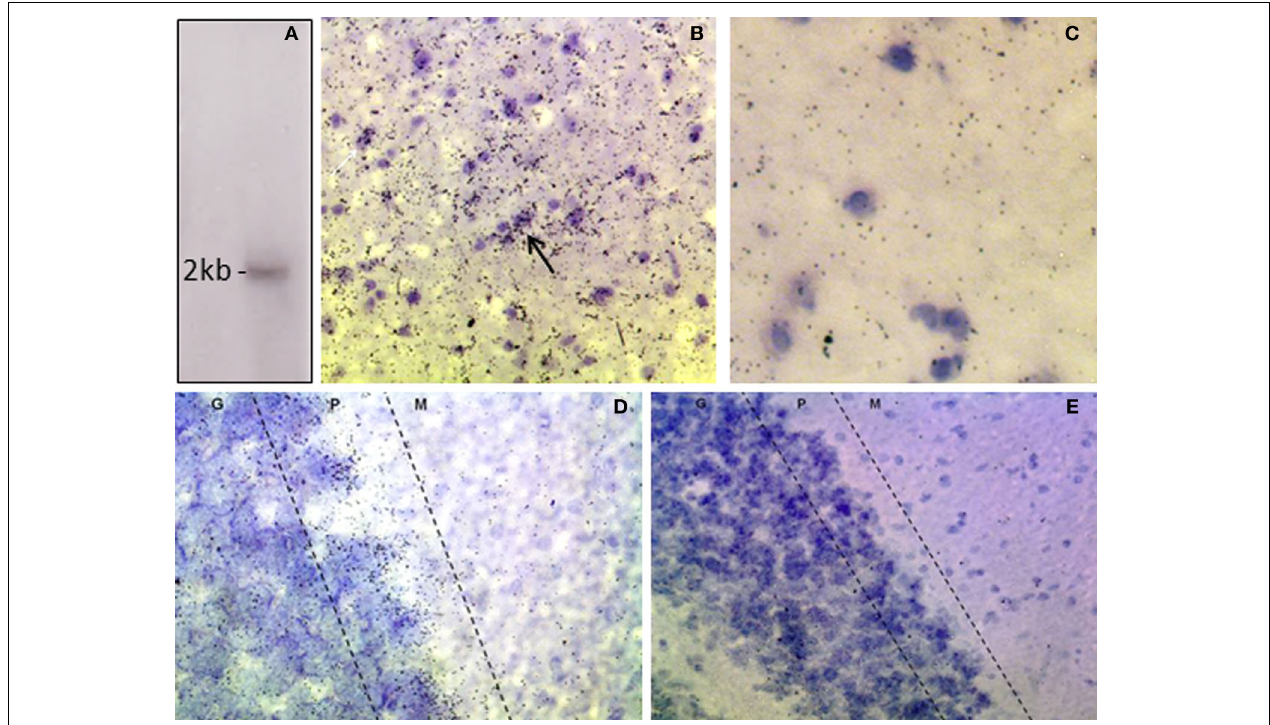
FIGURE 1 | Expression of DAO mRNA in rat VTA and cerebellum. (A) Northern blot of rat cerebellar RNA showing that the DAO cRNA probe detects a single band of ∼ 2kb. (B) In situ hybridization, showing signal for DAO mRNA in the VTA, with clusters of grains over neurons (arrow). (C) VTA, sense strand hybridization control, showing low level